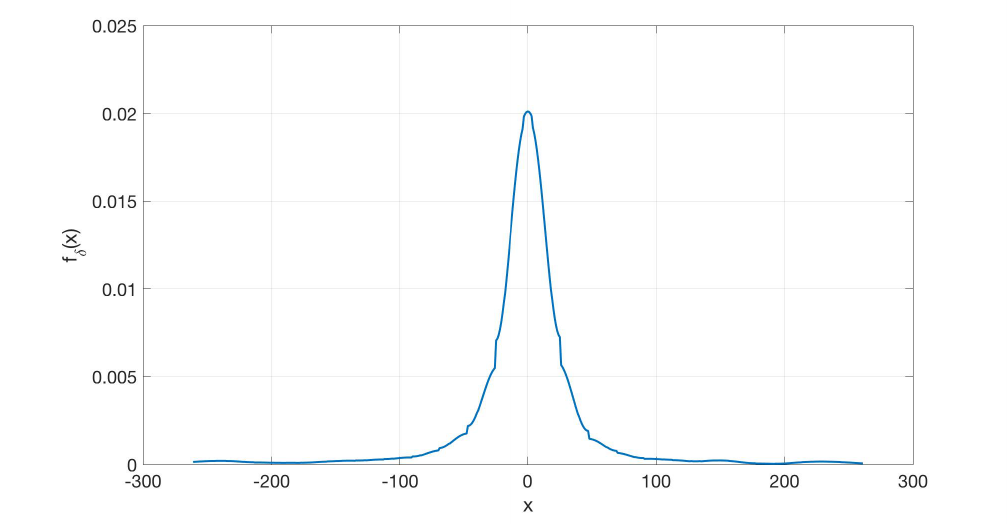
Figure 5. Distribution of the clock